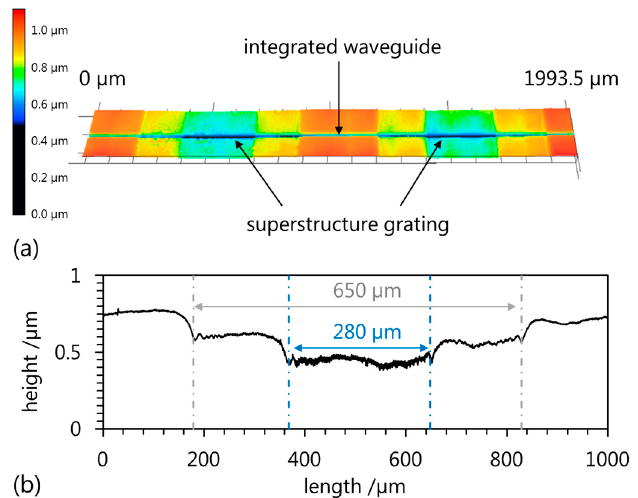
Figure 4. ( a ) Confocal laser scanning microscopy of the surface of a superstructure polymer planar Bragg grating indicating two grating segments and ( b ) height profile of one grating segment.